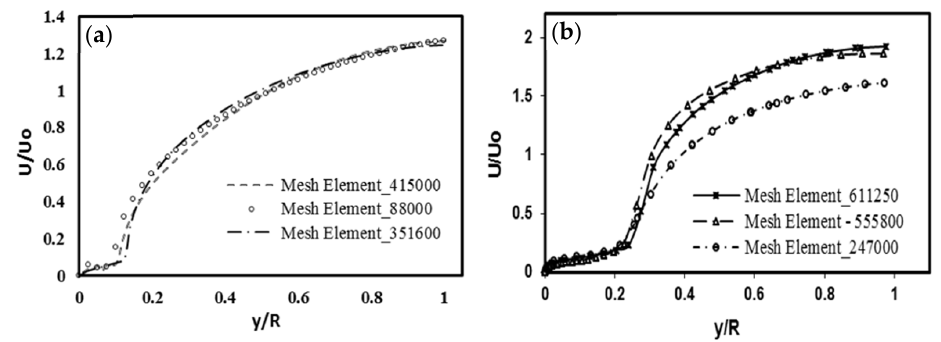
Figure 9. Mesh convergence study: ( a ) 2D simulation; ( b ) 3D simulation. Figure 9b gives 3D mesh convergence studies performed on three successive meshes of 247,100, 555,800 and 611,250 points. The mean velocity was also normalised by the bulk velocity at the centre line. Similar to 2D, the velocity exhibited a linear region from the